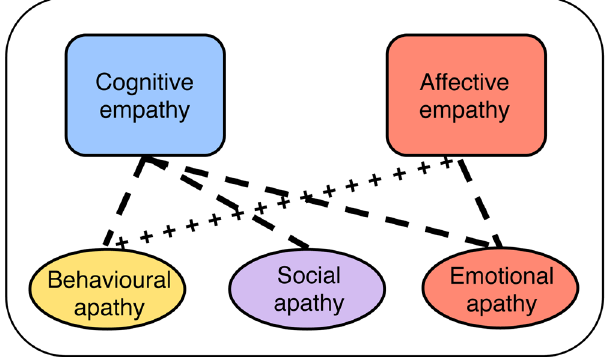
Figure 3. Schematic of associations between empathy and apathy-motivation. People higher in cognitive empathy are less behaviourally, socially and emotionally apathetic, i.e. more motivated in general. However, those higher in affective empathy are more behaviourally apathetic, but less emotionally apathetic. Factor analyses showed that lack of affective empathy and emotional apathy are underpinned by the same latent factor (red box and oval). Dashed lines represent negative associations and crossed lines represent positive associations from multiple regression analyses of unique variance associated with empathy and